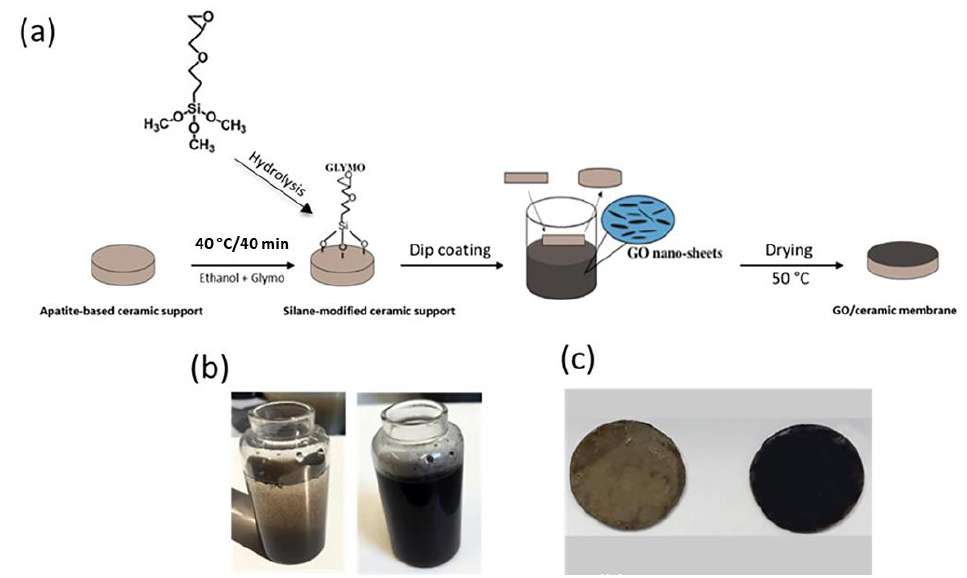
Figure 2. ( a ) Steps of the preparation of the GO/ceramic (phosphate) modified membrane; ( b ) the heterogeneous graphene oxide solution was heterogeneous without an ultrasound treatment ( left ) and was homogeneous and stable with an ultrasound treatment ( right ); ( c ) image of the ceramic support with silane-grafting after dip-coating using a GO solution of CGO = 0.5 mg/mL ( left ) and CGO = 2 mg/mL ( right